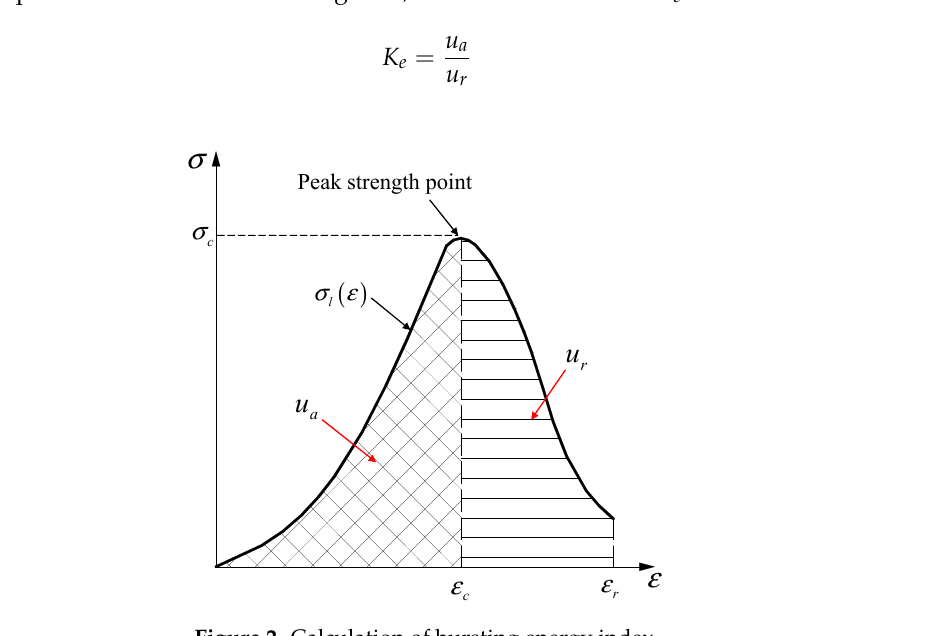
Figure 2. Calculation of bursting energy index.